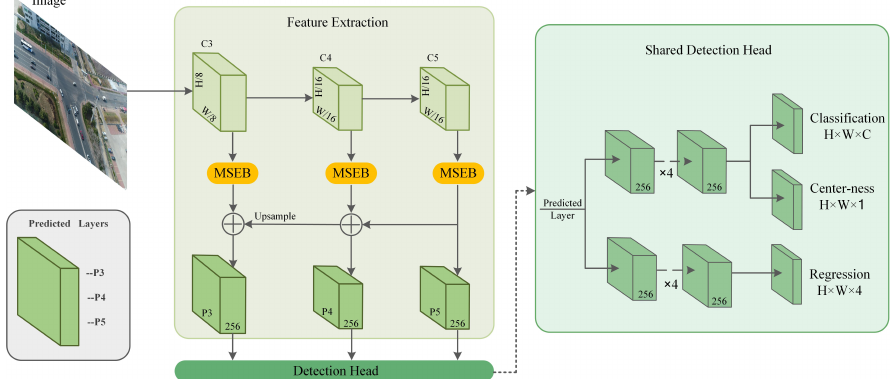
Figure 1. The over architecture of the FEAF network, including feature extraction and shared detection head. The MSEB is a multi-scale semantic enhancement block to strengthen semantic